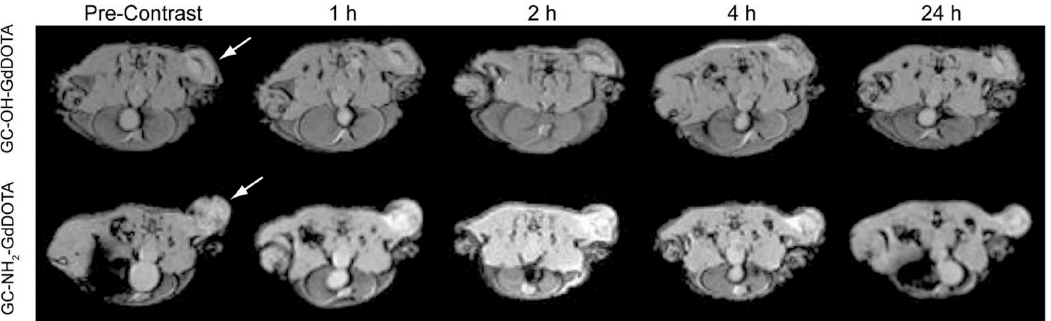
Figure 2. T 1 -weighted axial-view magnetic resonance (MR) images of nu/nu mice T6-17 flank tumors 1, 2, 4 and 24 h after injection of 30 μ mol/kg contrast agent. Tumor areas are indicated by white arrows. Abbreviations: GC, glycol chitosan polymer; DOTA, 1,4,7,10-tetraazacyclododecane-1,4,7,10-tetraacetic acid 1-(2,5-dioxo-1-pyrrolidinyl) ester (Adapted with permission from [31]. Copyright 2013 American Chemical Society). GC, glycol chitosan.